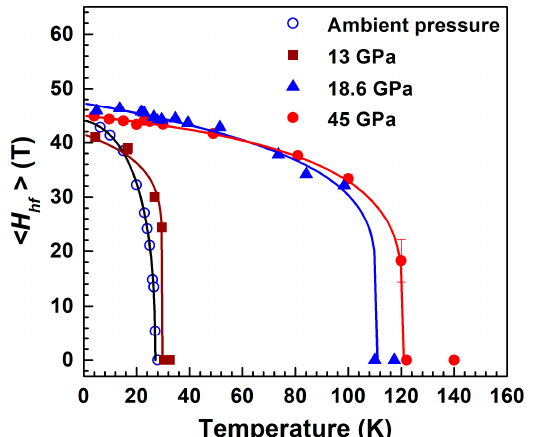
Figure 8. (Colour on-line) Temperature dependences of the average values of magnetic hyperfine field < H hf > at iron nuclei in the magnetic fraction of langasite Ba 3 NbFe 3 Si 2 O 14 estimated from Mössbauer spectra at different pressures before and after the structural transitions. Solid lines are empirical function describing the pressure-temperature dependence of the field H hf (P,T) [17].